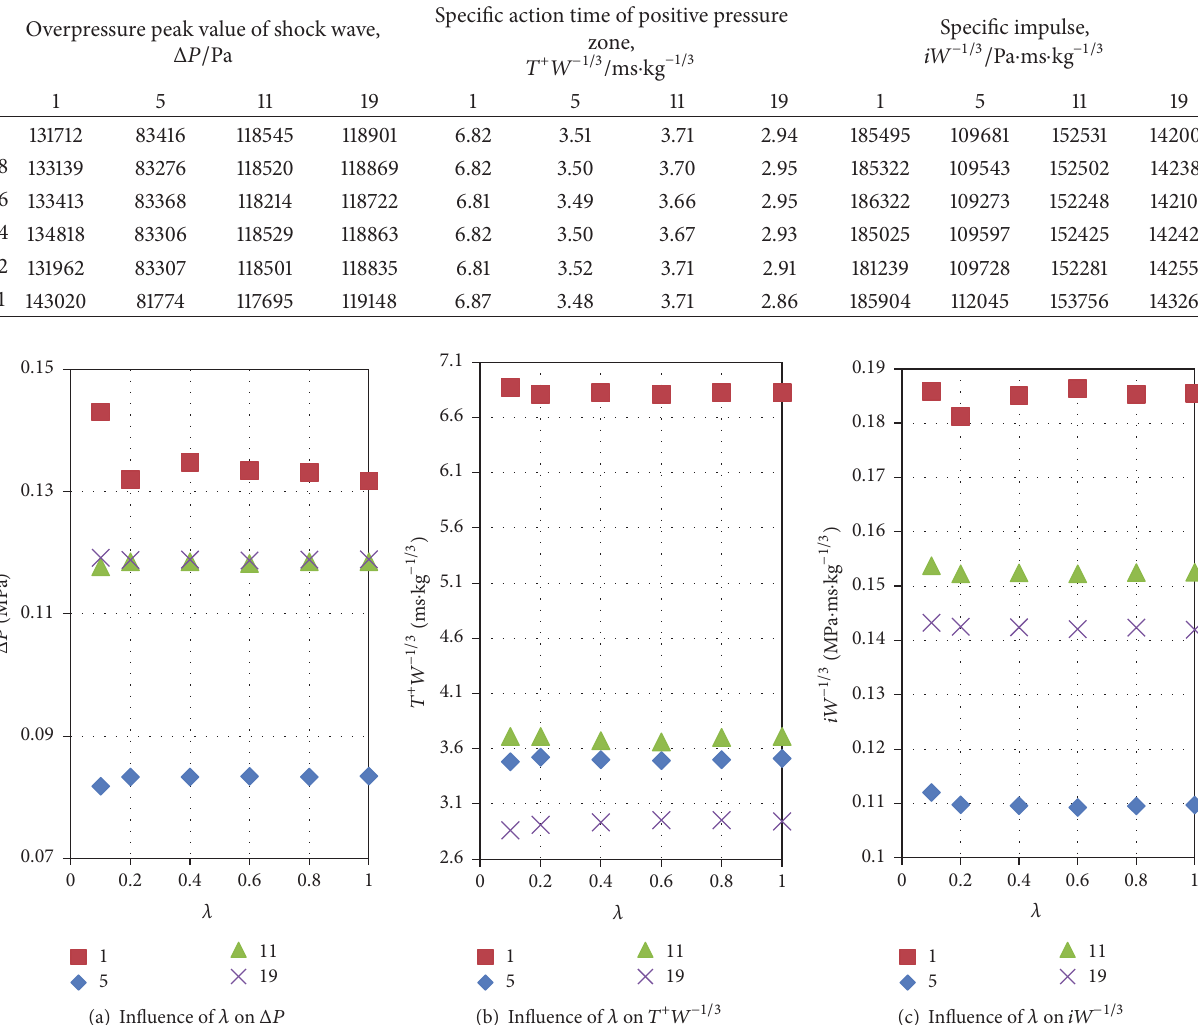
Table 5: Overpressure peak values at each unit position, specific action time of positive pressure zone, and specific impulse. Overpressure peak value of shock wave, Δ𝑃/ Pa 𝜆